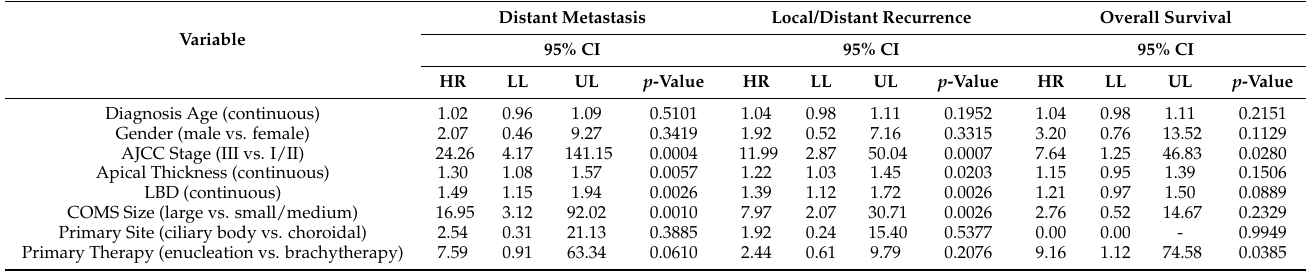
Figure 2. Overall survival for Class 1A UM patients who did (red line) or did not (blue line) develop distant metastasis is shown (top panel), including estimates for 1, 2, 3, and 5 years (bottom panel). Abbreviations: HR, Hazard ratio; LL, Lower limit; UL, Upper Limit; CI, Confidence interval. Table 2. Univariable analysis of